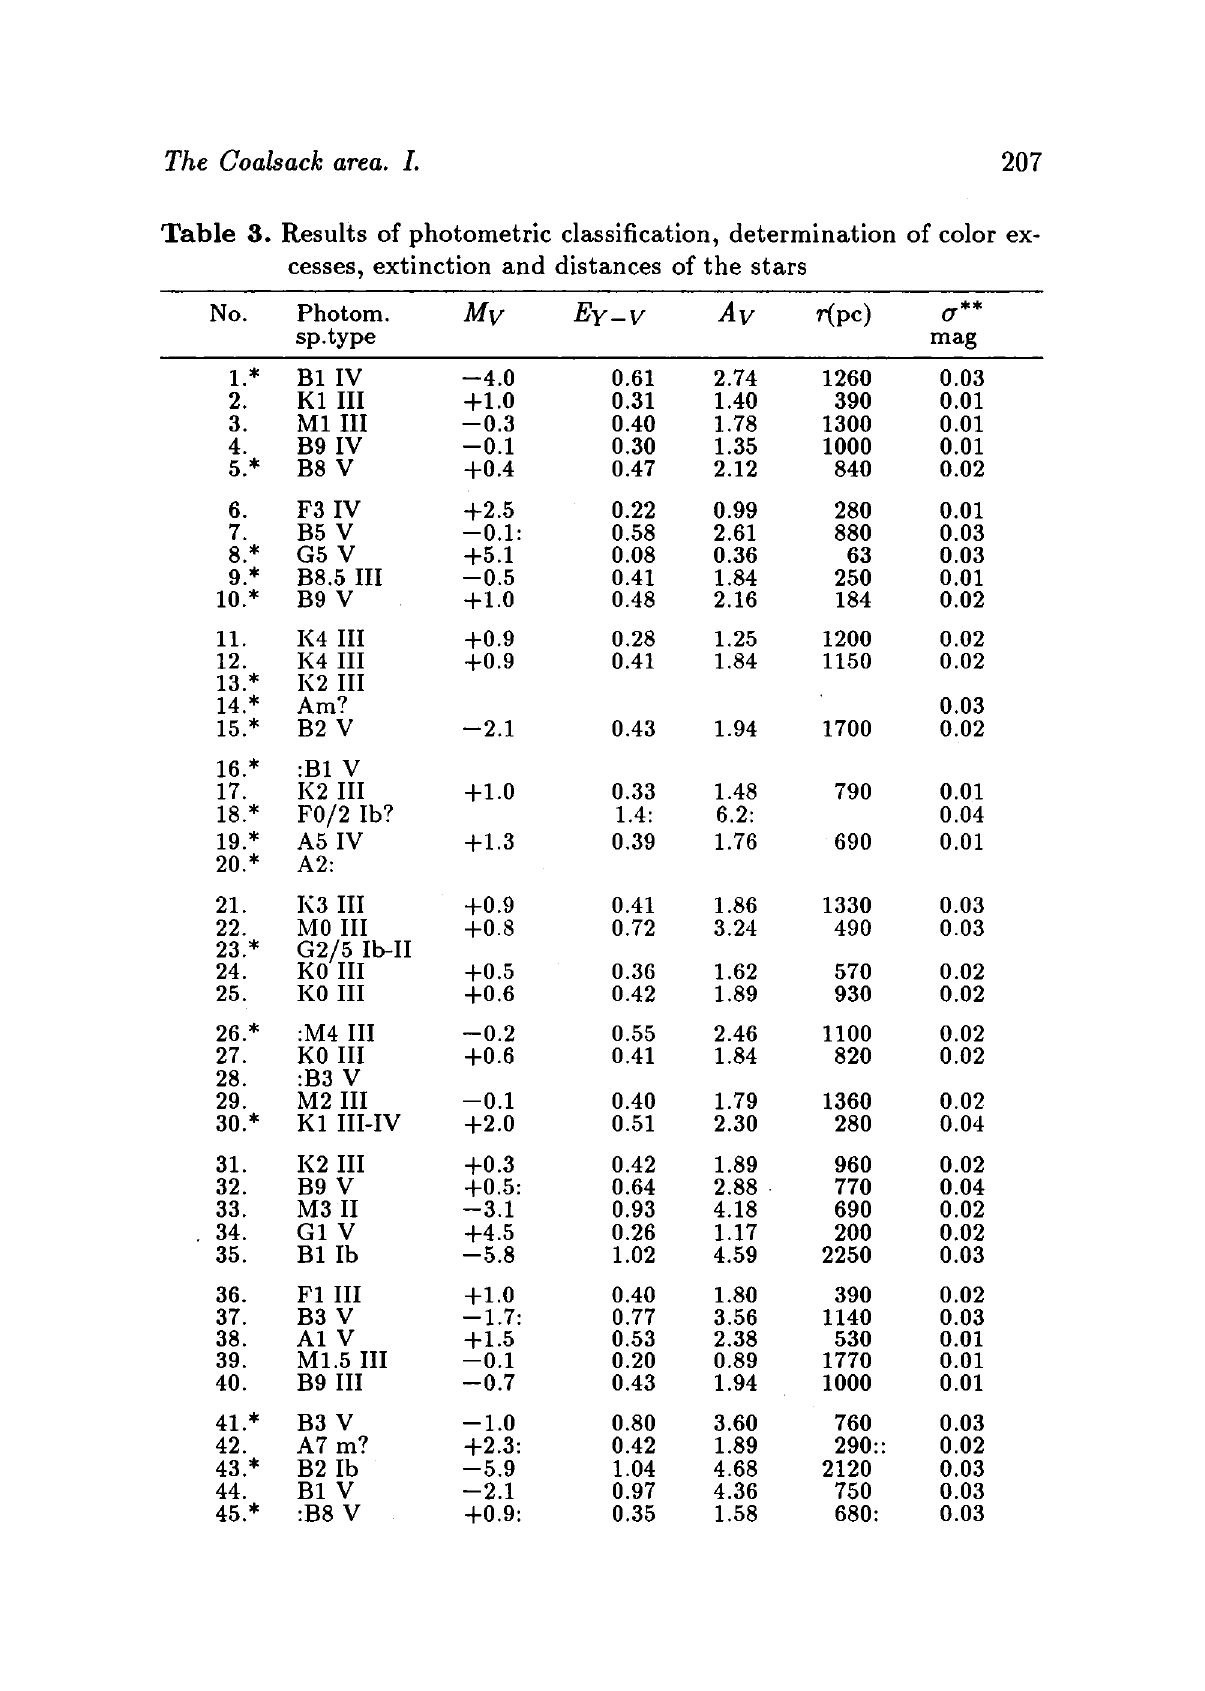
Table 3. Results of photometric classification, determination of color ex- cesses, extinction and distances of the